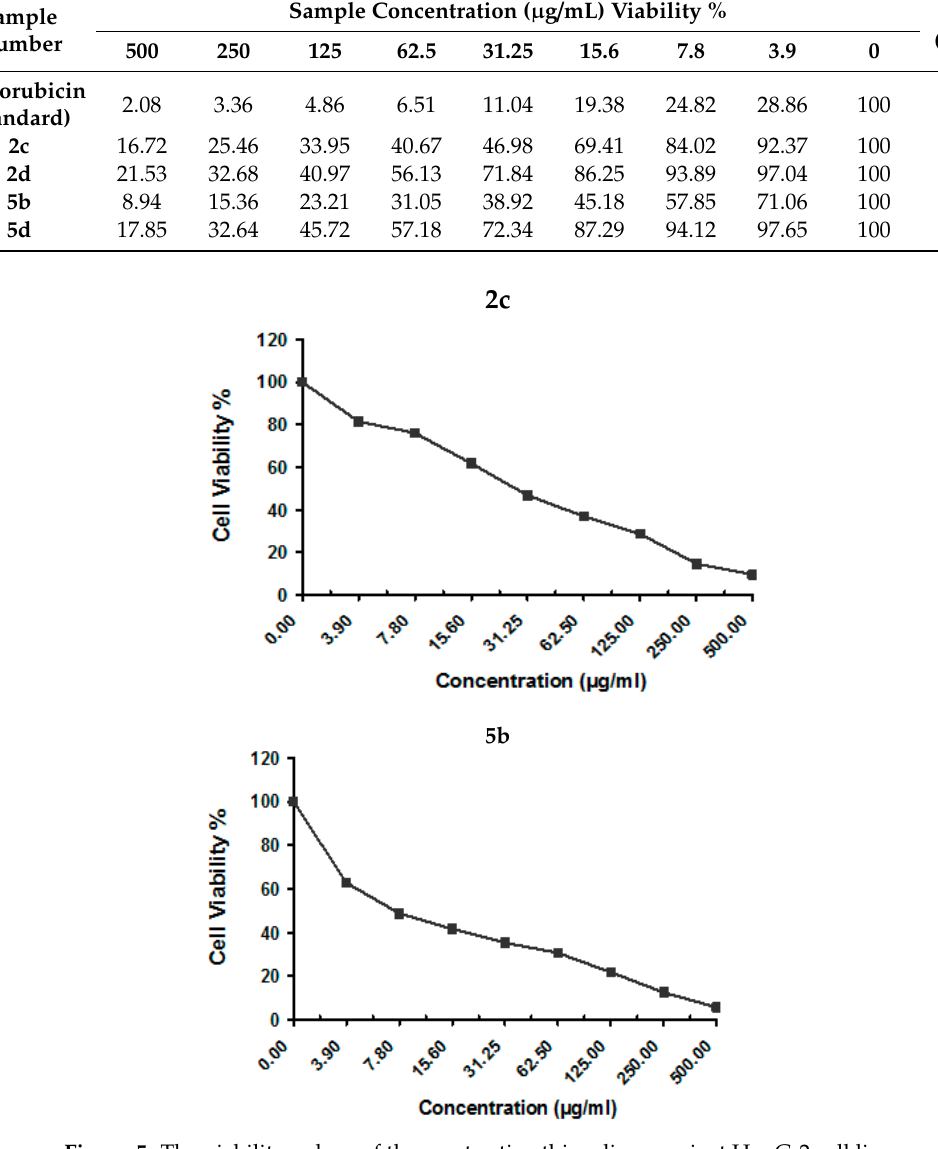
Figure 5. The viability values of the most active thiazolines against HepG-2 cell line.